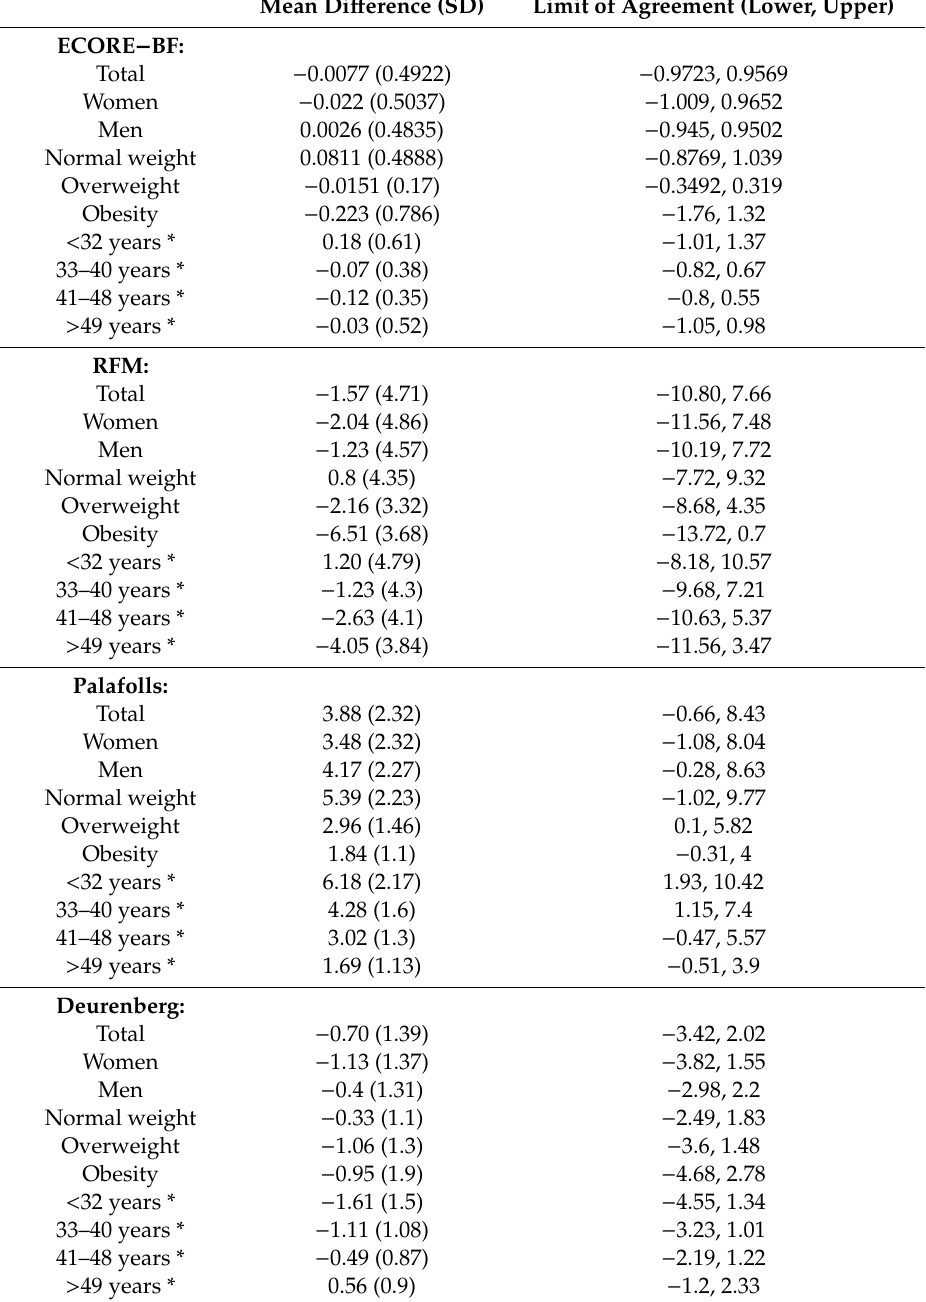
Table 5. Mean di ff erences between formulas and